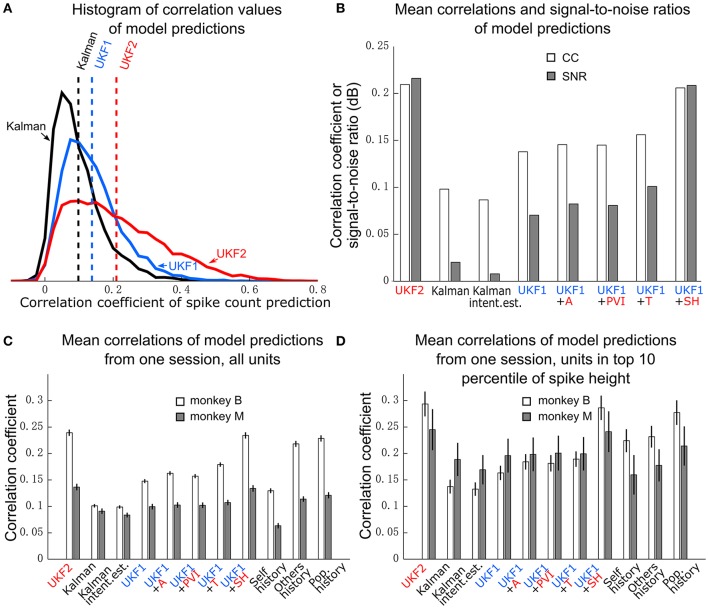
Encoding model prediction accuracy. (A) Histogram of spike count prediction accuracies measured by correlation coefficient. Dashed vertical lines indicate means for each encoding model. (B) Mean CC and SNR of each encoding model, including UKF1 augmented with each of: +A, acceleration; +PVI, position-velocity interaction; +T, target; +SH, spiking history of population. SEM was not calculated since data likely includes repeated observations of neurons. (C) Mean±SEM of CC from one session of each monkey when using all sorted units. (D) Mean ± SEM of CC from one session of each monkey when using units with mean spike height (peak to trough) in the top 10 percentile of all units in the session.